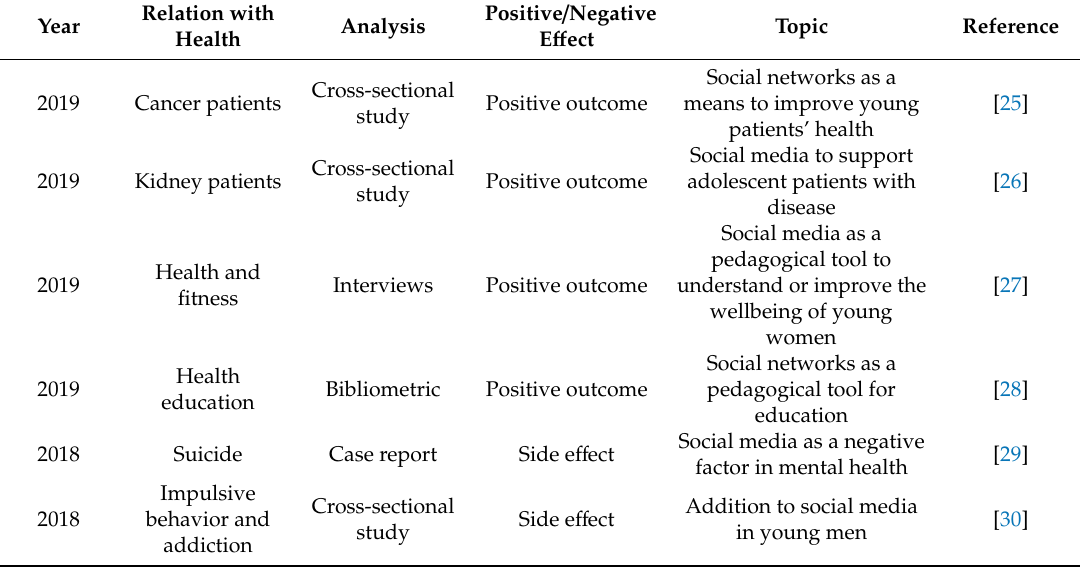
Table 1. Main areas of research on social networks related to health during the last 10